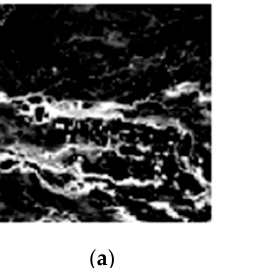
Figure 10. Guided mask map for the Gwydir site: ( a ) the water abundance map at prediction time (T2) and ( b ) guided mask map.